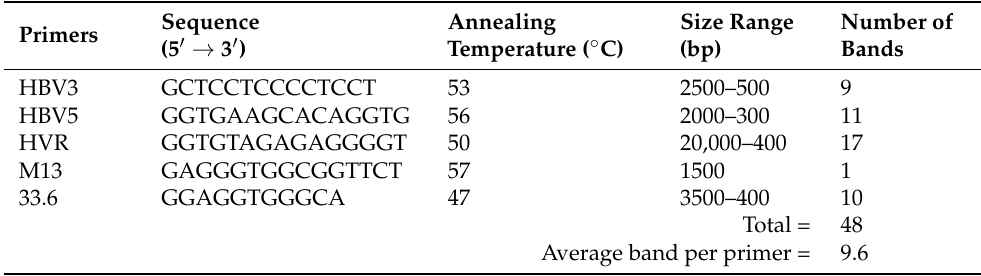
Table 1. DAMD primers screening for the genetic stability of Plectranthus amboinicus .